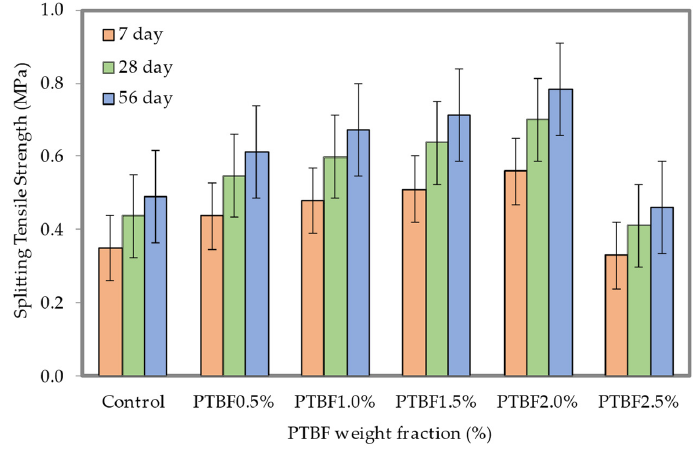
Figure 20. Tensile strength of 900 kg/m 3 density LFC with different weight fractions of PTBF.